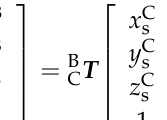
Figure 11. Coordinate systems involved in the coordinate transformation.